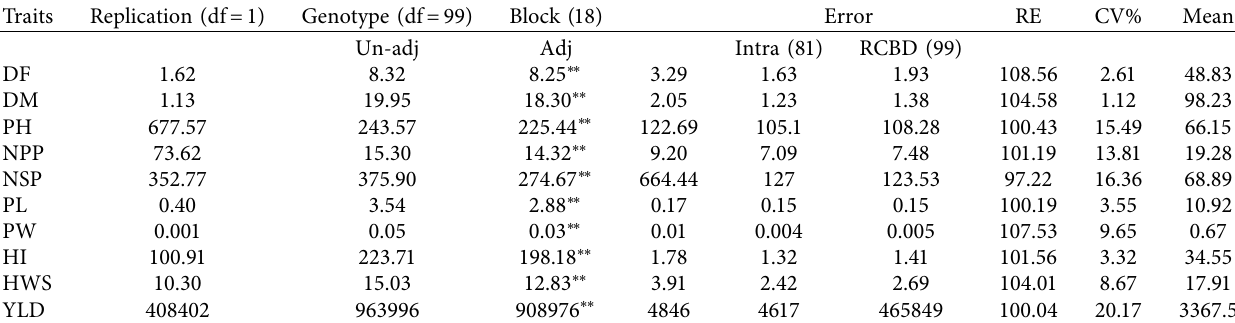
Table 2: Mean square values for the 10 characters of 100 haricot bean genotypes grown at Jimma (2020/21). Traits Replication (df � 1)